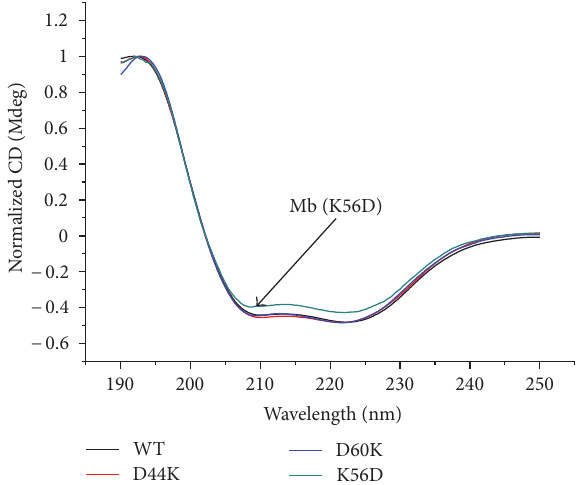
F 9: CD spectra of 5